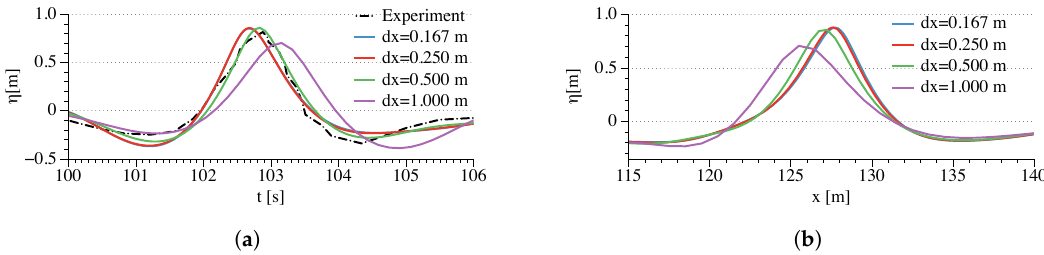
Figure 1. Grid convergence study of the focusing wave group generated using a wave packet method. ( a ) Comparison of time series at the designated focusing location with different grid sizes. The time series are also compared to the measurements. ( b ) Comparison of wave profiles at the designated focusing time with different grid sizes.